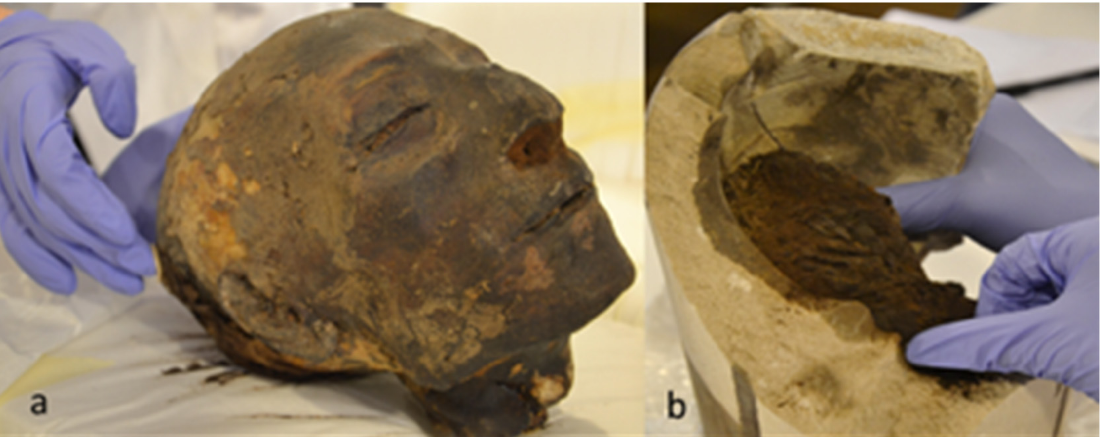
Figure 1. Pictures of the head of Nebiri ( a ) and of the canopic jar containing the lungs ( b ) taken during the non-invasive sampling procedure.